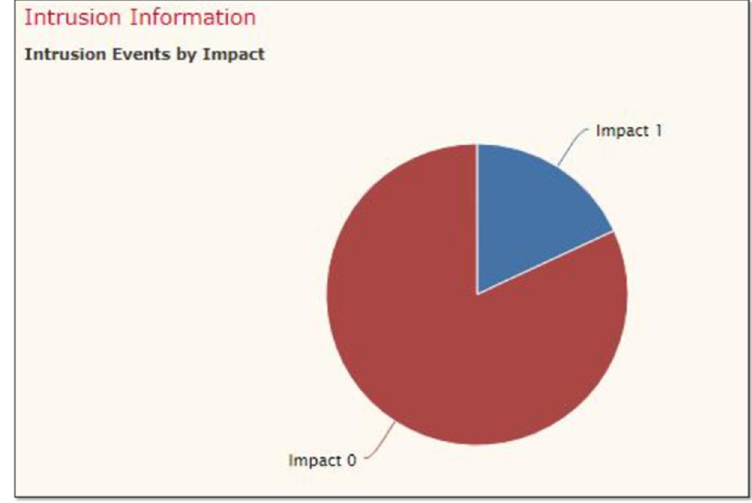
Figure 9. Intrusion Event by Impact extracted from Firepower.